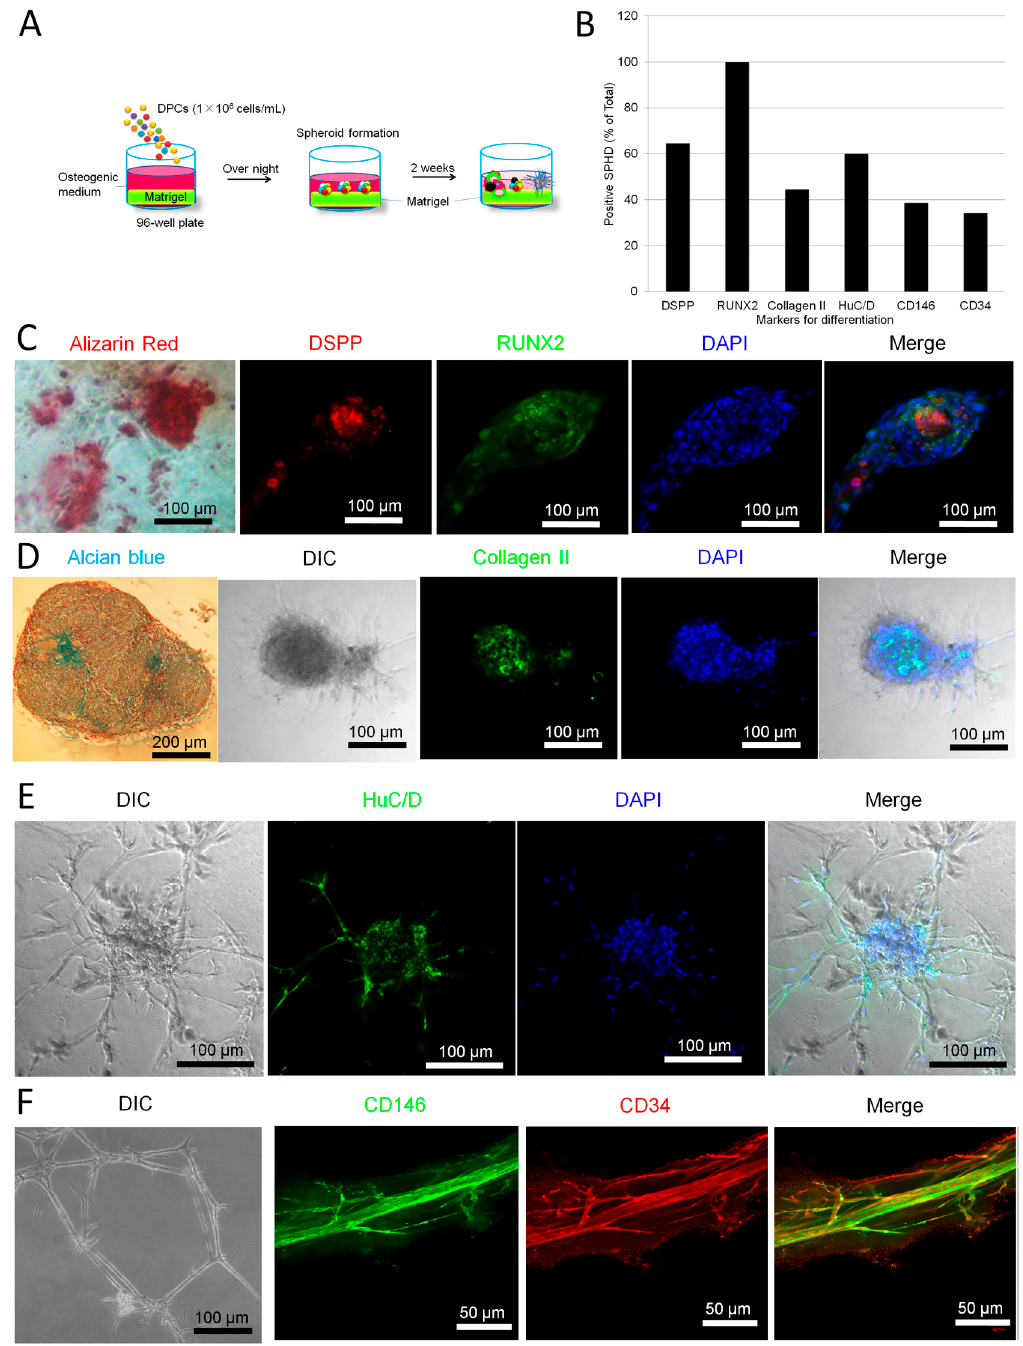
Figure 2. Multi-differentiation of dental pulp cell (DPC)-formed spheroids. Human dental pulp cells (1 × 10 6 ) were seeded on matrigel in osteogenic medium overnight. The cells spontaneously formed spheroids. After further cultivation for 2 weeks, the spheroids differentiated into multi-lineage cell masses. ( A ) Experimental setup; ( B ) The spheroids were cultivated in osteogenic medium in 96-well plates for 14 days. The spheroids were followed by alizarin red, alcian blue and immunofluorescence staining. Five wells were prepared for each marker. The markers (antibodies) include DSPP, RUNX2, collagen II, HuC/D, CD146 and CD34. The positive cell masses for each marker were counted in every 10 spheroids per well × 5 wells/antibody; ( C – F ) Typical images of differentiated spheroids ( n = 5). Data represent three independent experiments.